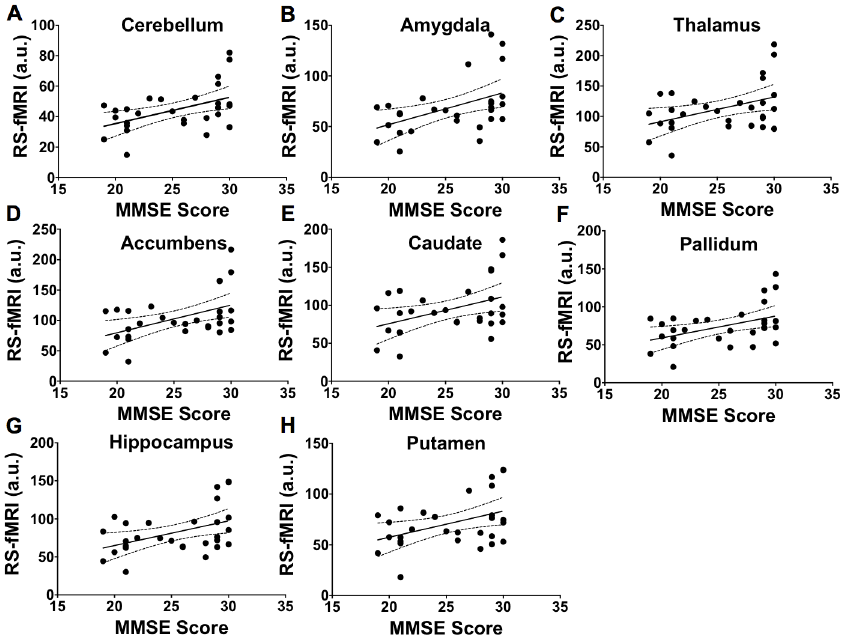
Fig 7. Relationship between mean brain activities measuredusing RS-fMRI and cognition function. The 95% confidenceintervals for the regressionsare shown as dotted lines. AssociationbetweenMMSE score and brain activity in cerebellum(r = 0.50, p = 0.007, A), amygdala(r = 0.47, p = 0.009, B), thalamus (r = 0.42, p = 0.02, C), accumbens (r = 0.48, p = 0.008, D), caudate(r = 0.41, p = 0.02, E), pallidum(r = 0.44, p = 0.01, F), hippocampus (r = 0.44, p = 0.01, G), and putamen(r = 0.41, p = 0.02, H). These correlationswere not significantfollowingBonferroni correction for